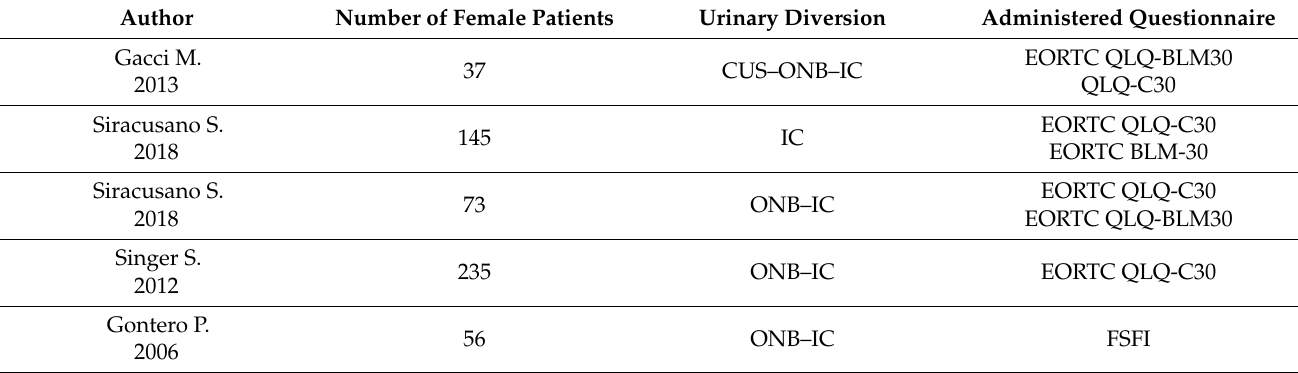
Table 2. Studies published on QoL in cystectomized female patients (CUS, cutaneous ureterostomy; ONB, orthotopic neobladder; IC, ileal